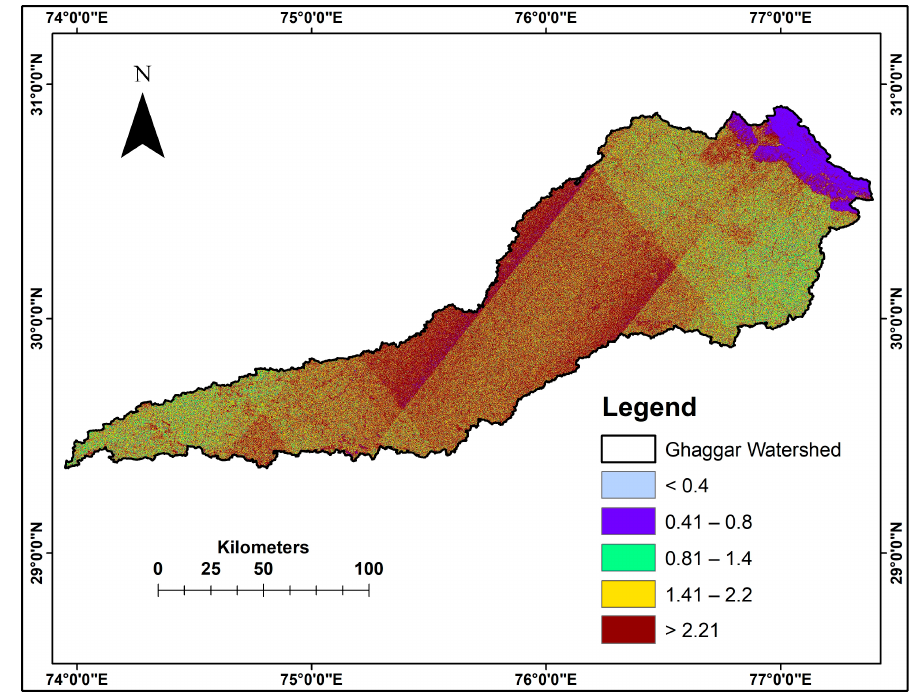
Figure 10. Slope classification of the study area. Table 5. Slope area statics of study area and its classification.